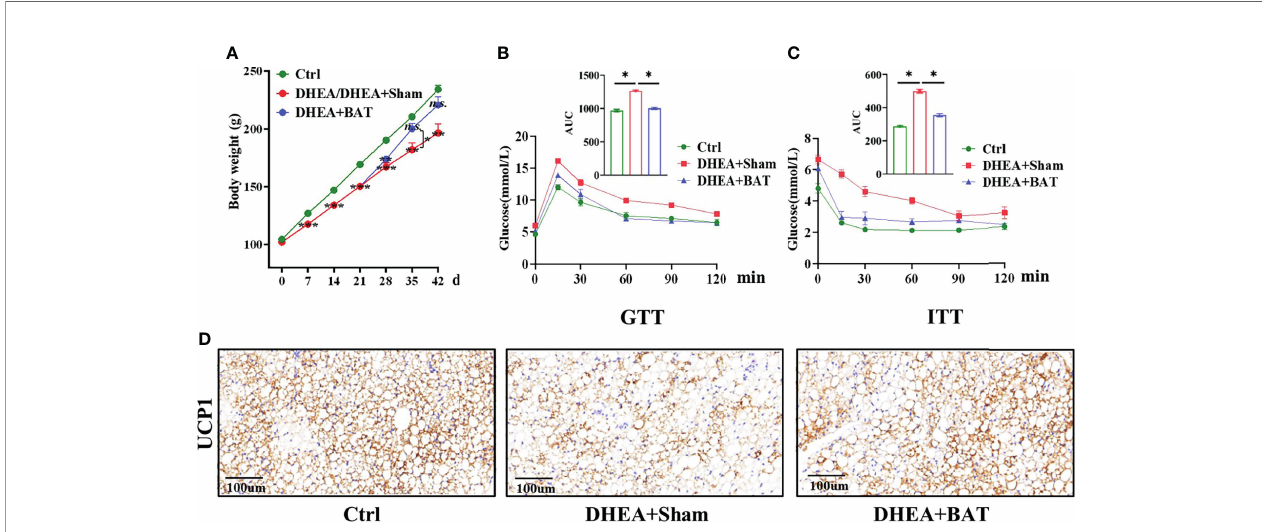
FIGURE 3 | Brown adipose tissue (BAT) transplantation partially corrected the metabolic abnormality of polycystic ovary syndrome (PCOS) model rats. (A) Comparison of the mean weight among the control (Ctrl) group, the DHEA/DHEA+Sham group, and the DHEA+BAT group. (B, C) Results of the GTT (B) and ITT (C) showed that insulin resistance was rescued by BAT transplantation in PCOS model rats. (D) UCP1 expression was reduced in the DHEA+Sham group and was enhanced in the DHEA+BAT group. GTT , glucose tolerance test; ITT , insulin tolerance test; UCP1 , uncoupling protein 1. Data were analyzed using one-way